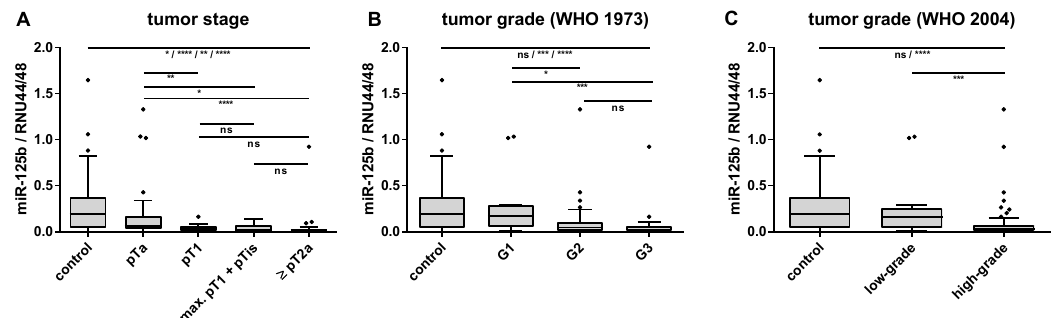
Figure 1. Dependence of the relative miR-125b expression levels (normalized to the geometric mean of the reference RNAs RNU44 and RNU48) in urine sediments on histopathological factors. The relationships between urinary miR-125b expression levels and tumor stage ( A ), as well as tumor grade according to the WHO classifications from 1973 ( B ) and from 2004 ( C ) are shown. Differences were tested by the Mann–Whitney U test. ns, not significant; * p < 0.05; ** p < 0.01; *** p < 0.001; **** p < 0.0001.